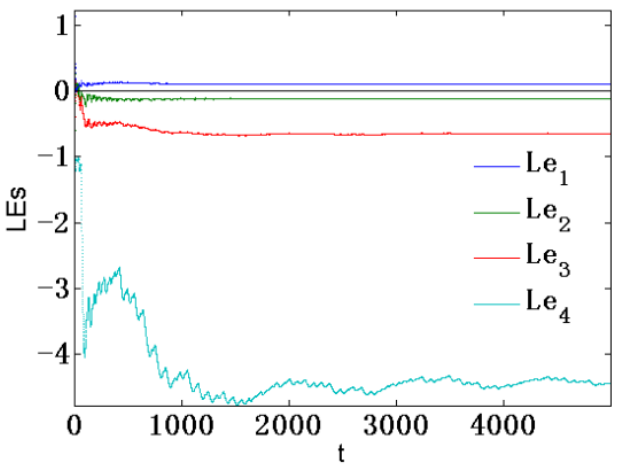
Figure 10. Lyapunov exponents in system (4) when β = 0.3.